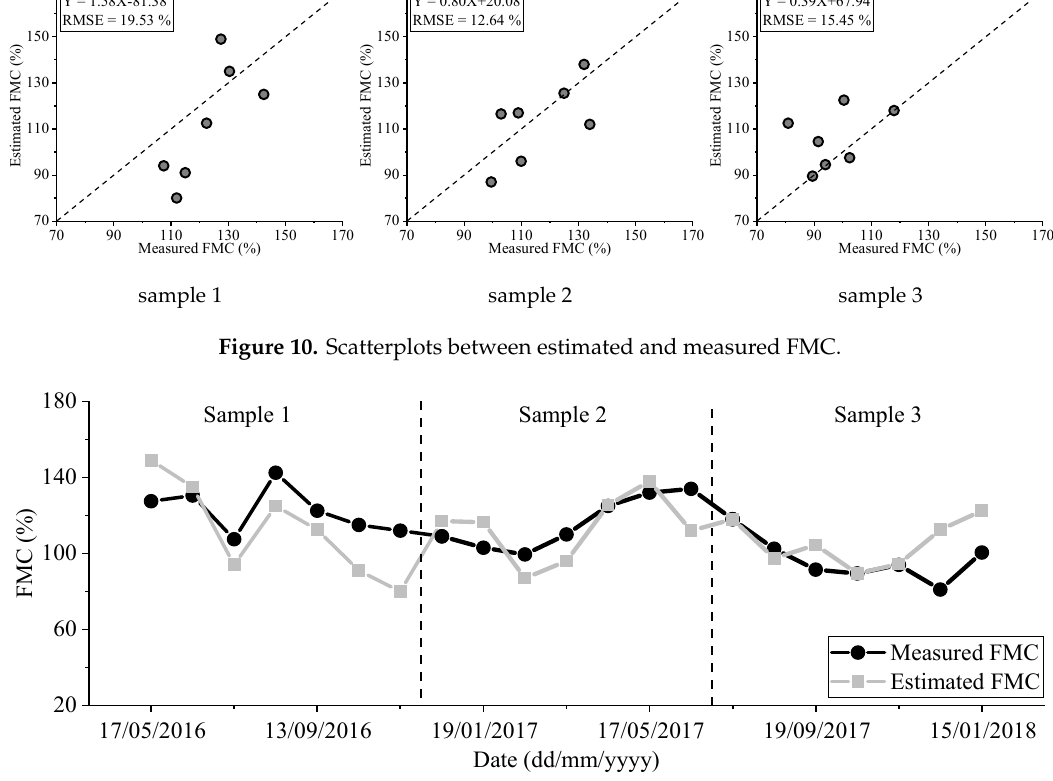
Figure 11. The time-series distribution of estimated and measured FMC.